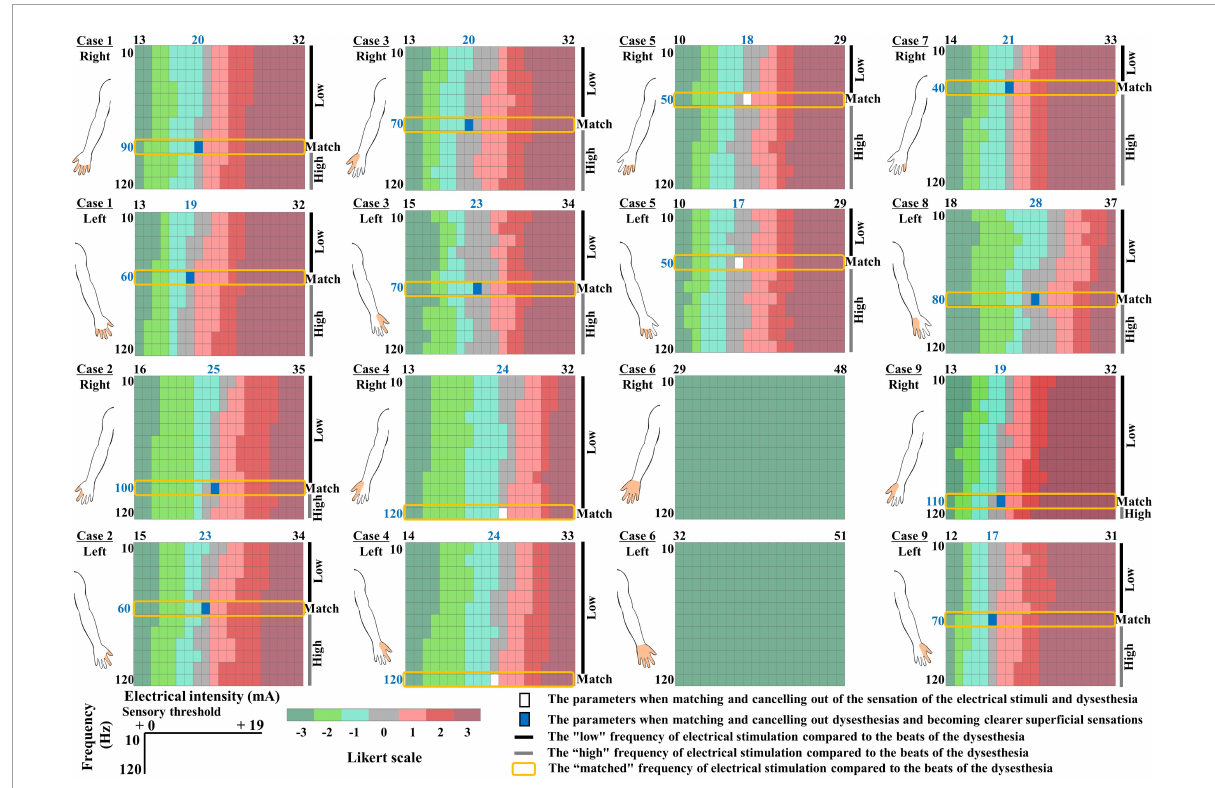
FIGURE3 Color map depicting the relationship between dysesthesias and each intensity of electrical stimulation. Seven-point Likert scale as follows: -3: “much stronger feeling of dysesthesia than the electrical stimulation,” -2: “feeling the dysesthesia more than the electrical stimulation,” -1: “slight feeling of dysesthesia compared to the electrical stimulation,” 0: “the same intensity of dysesthesia and the electrical stimulation but they are “distinguishable,”” 1: “slightly greater feeling of the electrical stimulation than the dysesthesia,” 2: “feeling the electrical stimulation more than the dysesthesia,” and 3: “much stronger feeling of the electrical stimulation than the dysesthesia.” Color bar: A seven-point Likert scale of the relationship between dysesthesia and each intensity of electrical stimulation. Filled white area: The parameters when the intensity and frequency of the electrical stimulation match the dysesthesia profile. Filled blue area : The parameters that canceled out dysesthesias, and superficial sensations became clearer. Blue fonts : The dysesthesia-matched intensity and frequency of the electrical stimulation. The filled orange area in the illustration of the upper limb indicates the area of